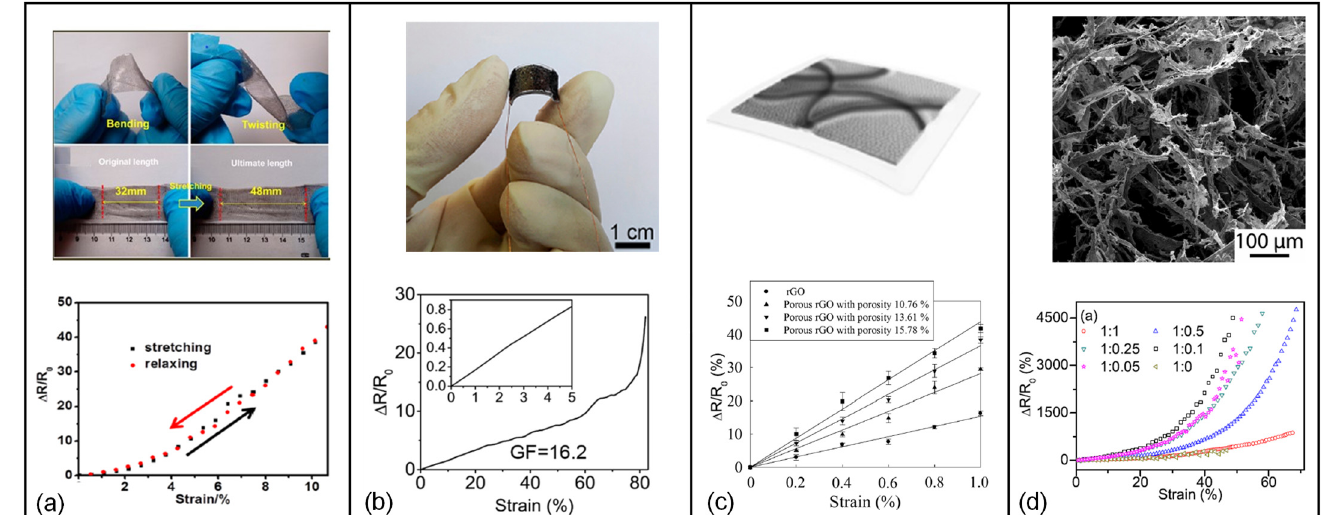
Figure 7. rGO graphene-based strain gauges: ( a ) digital photos of arbitrarily bent and twisted strain sensor and the relative resistance changes versus strain curves of the strain sensor under various strains. “Adapted with permission from ref. [172] . Copyright (2015) American Chemical Society.” ( b ) photograph of rGO strain sensor and relative resistance-strain curve of a rGO strain sensor recorded at a stretching rate of 10% min − 1 . “Adapted with permission from ref. [177] . Copyright (2016) American Chemical Society.” ( c ) porous rGO membrane on a PET substrate and the relative variation of resistance versus strain for rGO and porous rGO membranes with different membrane porosities, “Reprinted with permission from ref. [168] . Copyright (2016)AIP Publishing”. ( d ) SEM images of the cellulose-rGO composites and the relative resistance change, R/R 0 , as a function of the applied strain, “Reprinted with permission from ref. [169] . Copyright (2018) Elsevier”.